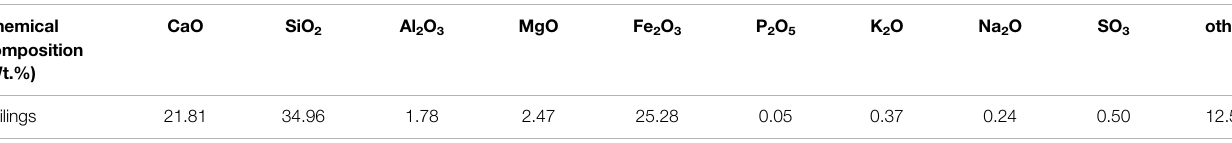
TABLE 1 | Chemical composition of tailings used.